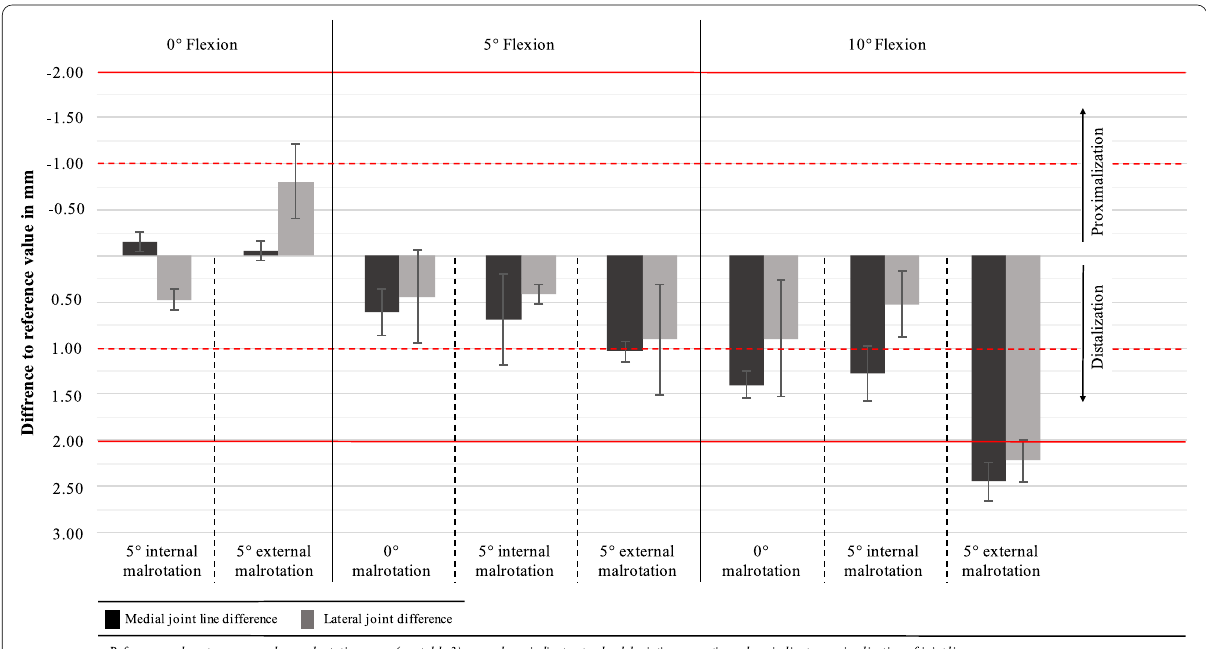
Fig. 5 Differences to reference values of medial and lateral joint line